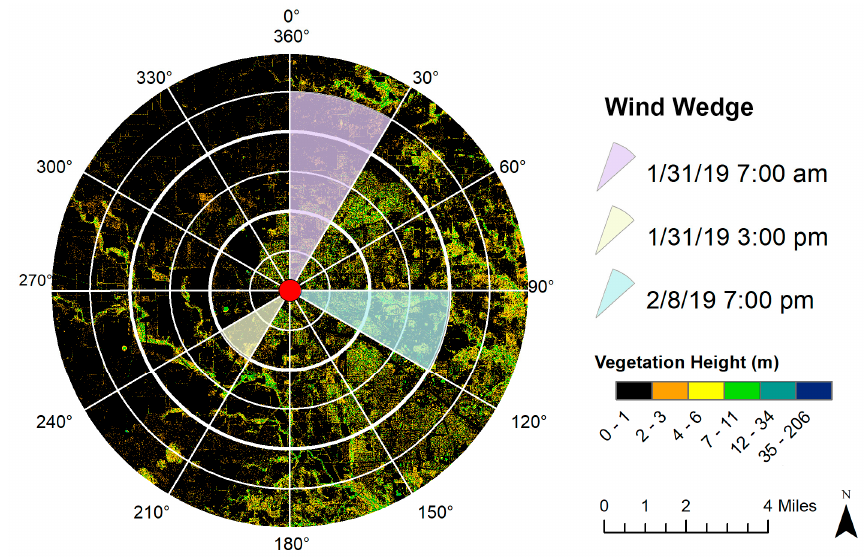
Figure 5. Wind wedge used in the explanatory variable calculation. Dates and the associated wind parameters are only for illustration purposes.